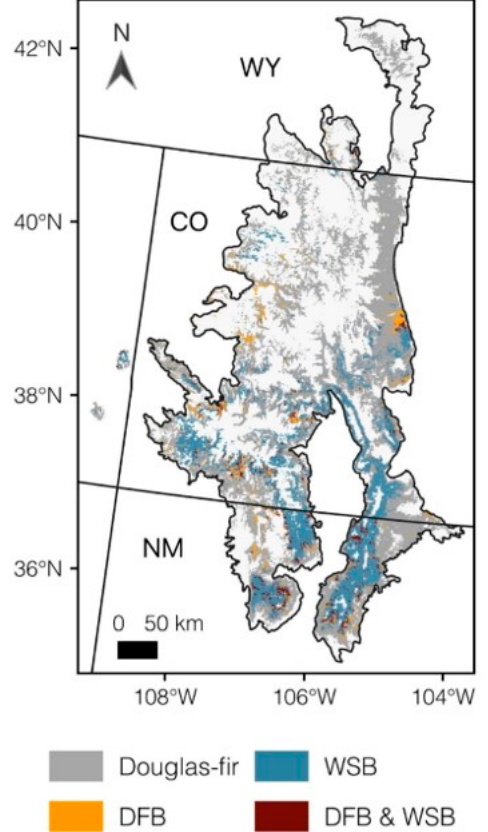
Figure 1. The Southern Rocky Mountain ecoregion (i.e., EPA Level III Ecoregion #21) and the range of Douglas-fir (gray), recent defoliation due to western spruce budworm (blue), recent tree mortality due to Douglas-fir beetle (yellow), and their intersection (dark red). Here, presence represents all 960 × 960 m pixels where at least 25% (four or more 240 × 240 m subpixels) listed presence. All layers were restricted to the distribution of Douglas-fir. Lines illustrate state boundaries.